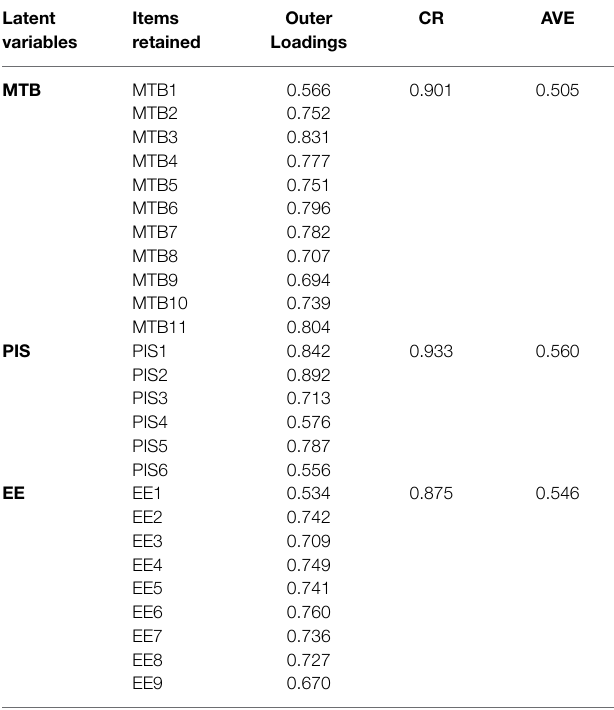
TABLE 2 | Results of reliability and validity. Latent Items variables